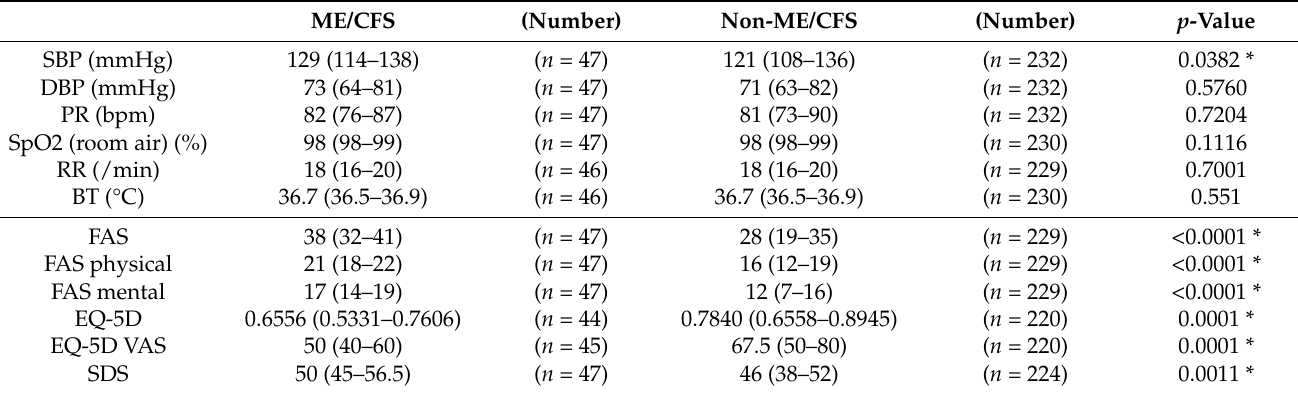
Figure 1. The most frequent symptoms in ME/CFS patients were general fatigue and PEM (42 patients, 89.4%), headache (16 patients, 34.0%), insomnia (11 patients, 23.4%), dysosmia (10 patients, 21.3%) and dysgeusia (9 patients, 19.1%). On the other hand, the most frequent symptoms in non-ME/CFS patients were general fatigue and PEM (104 patients, 44.8%), dysgeusia (81 patients, 34.9%), dysosmia (76 patients, 32.8%) hair loss (52 patients, 22.4%) and dyspnea (42 patients, 18.1%). Table 3. Vital signs and patient-reported questionnaires of ME/CFS and non-ME/CFS patients who visited the COVID-19 aftercare outpatient clinic.